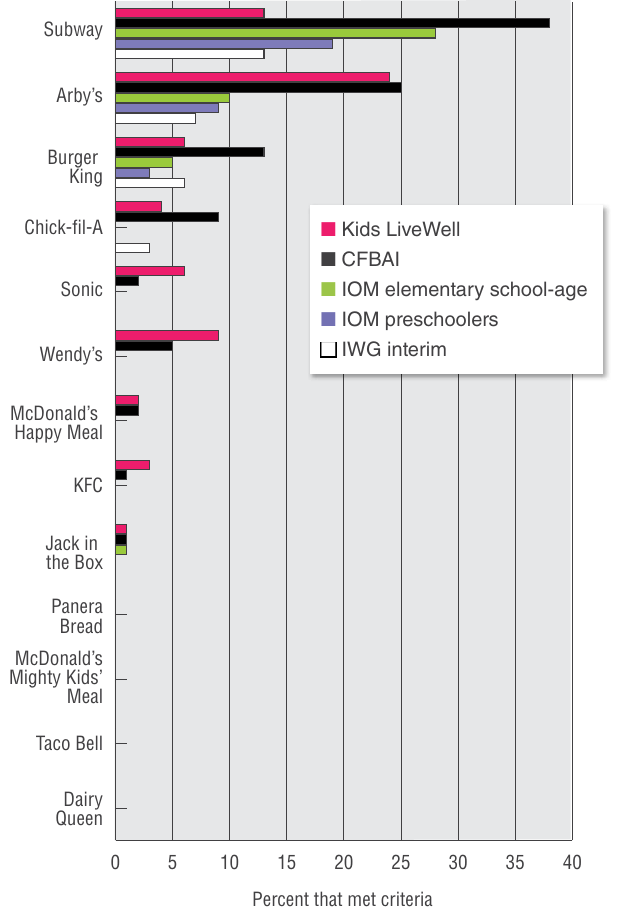
Figure 1. Percent of kids’ meals that met various nutrition standards for